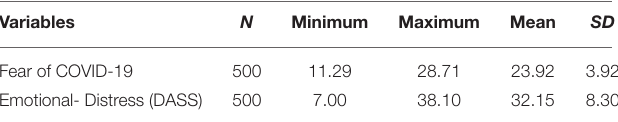
TABLE 2 | Descriptive statistics of the variables of the study ( N = 500).